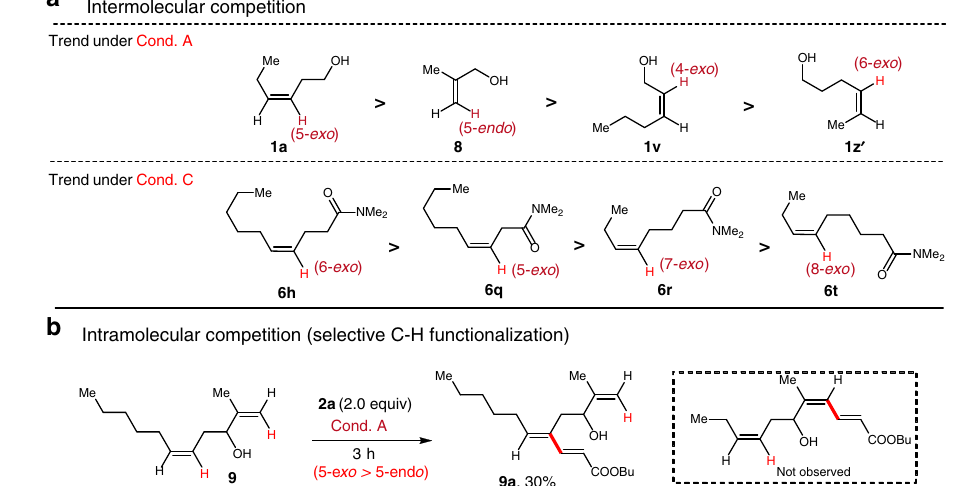
Fig. 2 Competition experiments. a Intermolecular competition experiments using alkenyl alcohols or alkenyl amides to rank the reaction trend under Cond. A or Cond C. b Intramolecular competition experiment using compound